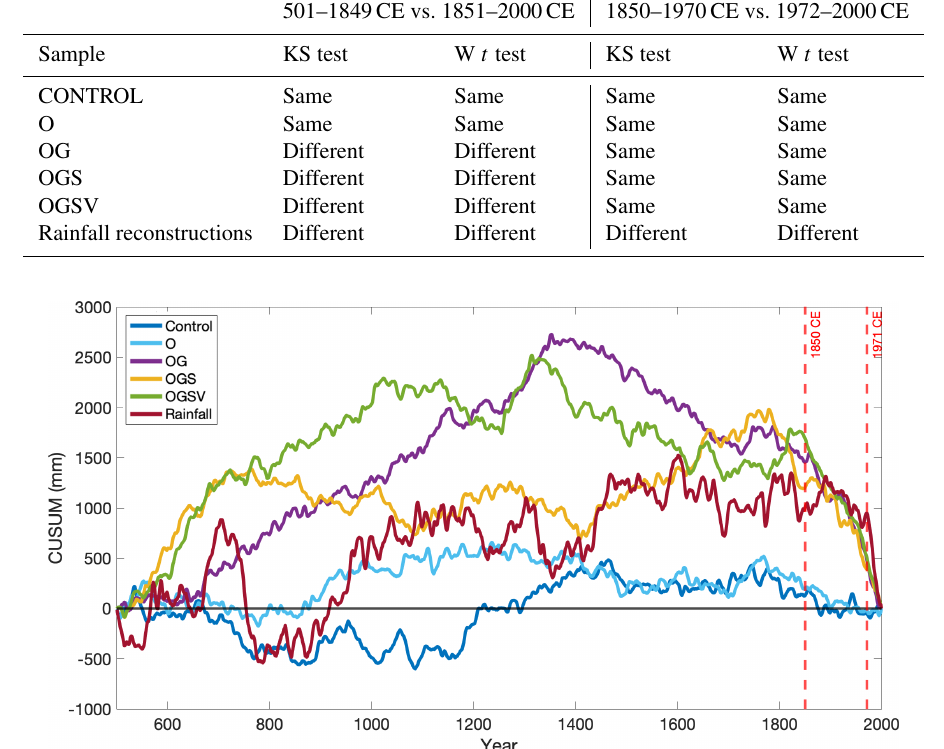
Table 4. The results for two independent statistical tests for different time periods from the rainfall time series. “KS test” is the two-sample KS test, and “W t test” is the Welch’s t test. “Same” means that we cannot reject the null hypothesis (the two samples of data are from the same distribution), whereas “Different” means that we can reject the null hypothesis ( p < 0.05).